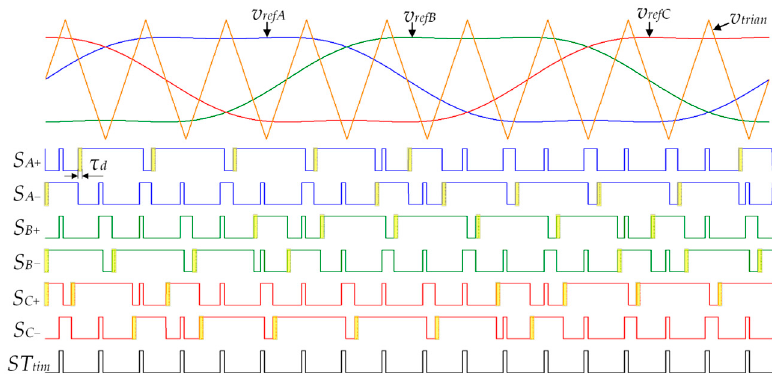
Figure 11. Waveforms of the utilized zero-sync SPWM with dead time (numerical simulation).